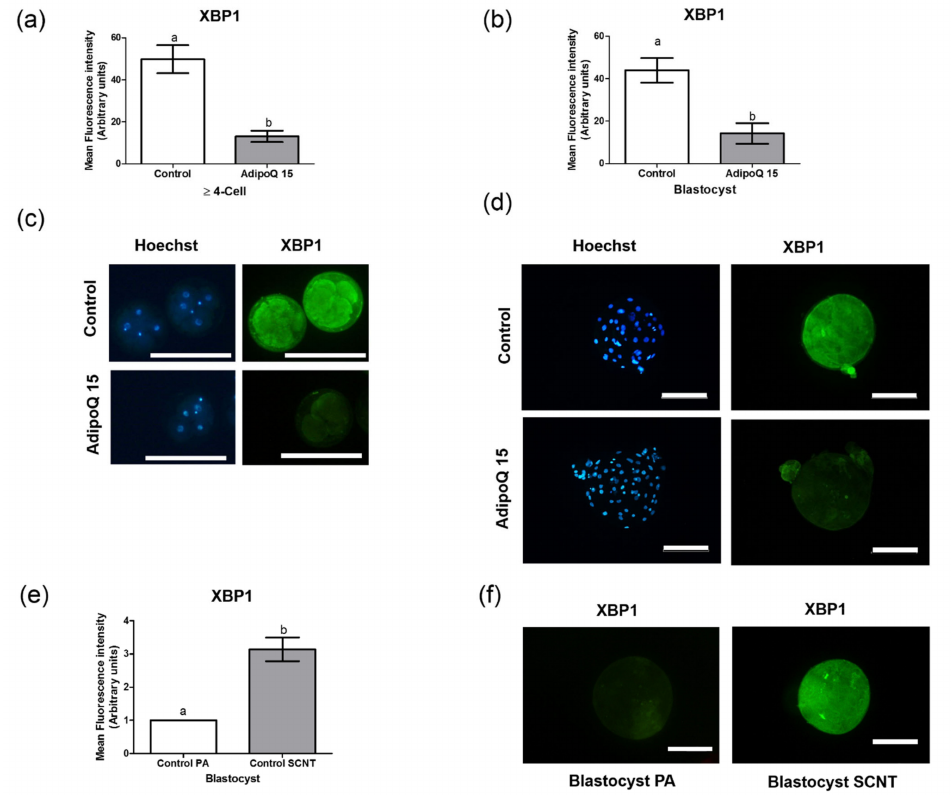
Figure 2. Effect of 15 µ g/mL adiponectin supplementation during in vitro culture of somatic cell nuclear transfer (SCNT) embryos on the protein expression of XBP1 in ≥ 4-cell embryos on day-2 ( a ) and in blastocysts ( b ); Hoechst (blue) and immunofluorescence (green) staining of control and adiponectin-treated ≥ 4-cell embryos (scale bars 200 µ m) ( c ) and blastocysts (scale bars 100 µ m) ( d ). Comparison of XBP1 expression in the blastocyst stage derived from parthenogenetic activation and SCNT (scale bars 100 µ m) ( e , f ). At least 24 embryos per group from 4 biological replicates were analyzed in each experiment. Data are expressed as mean ± SD. a,b Values with letters indicate significant difference ( p < 0.05). The experiment was performed as at least three independent replicates. AdipoQ 15 = adiponectin 15 µ g/mL.